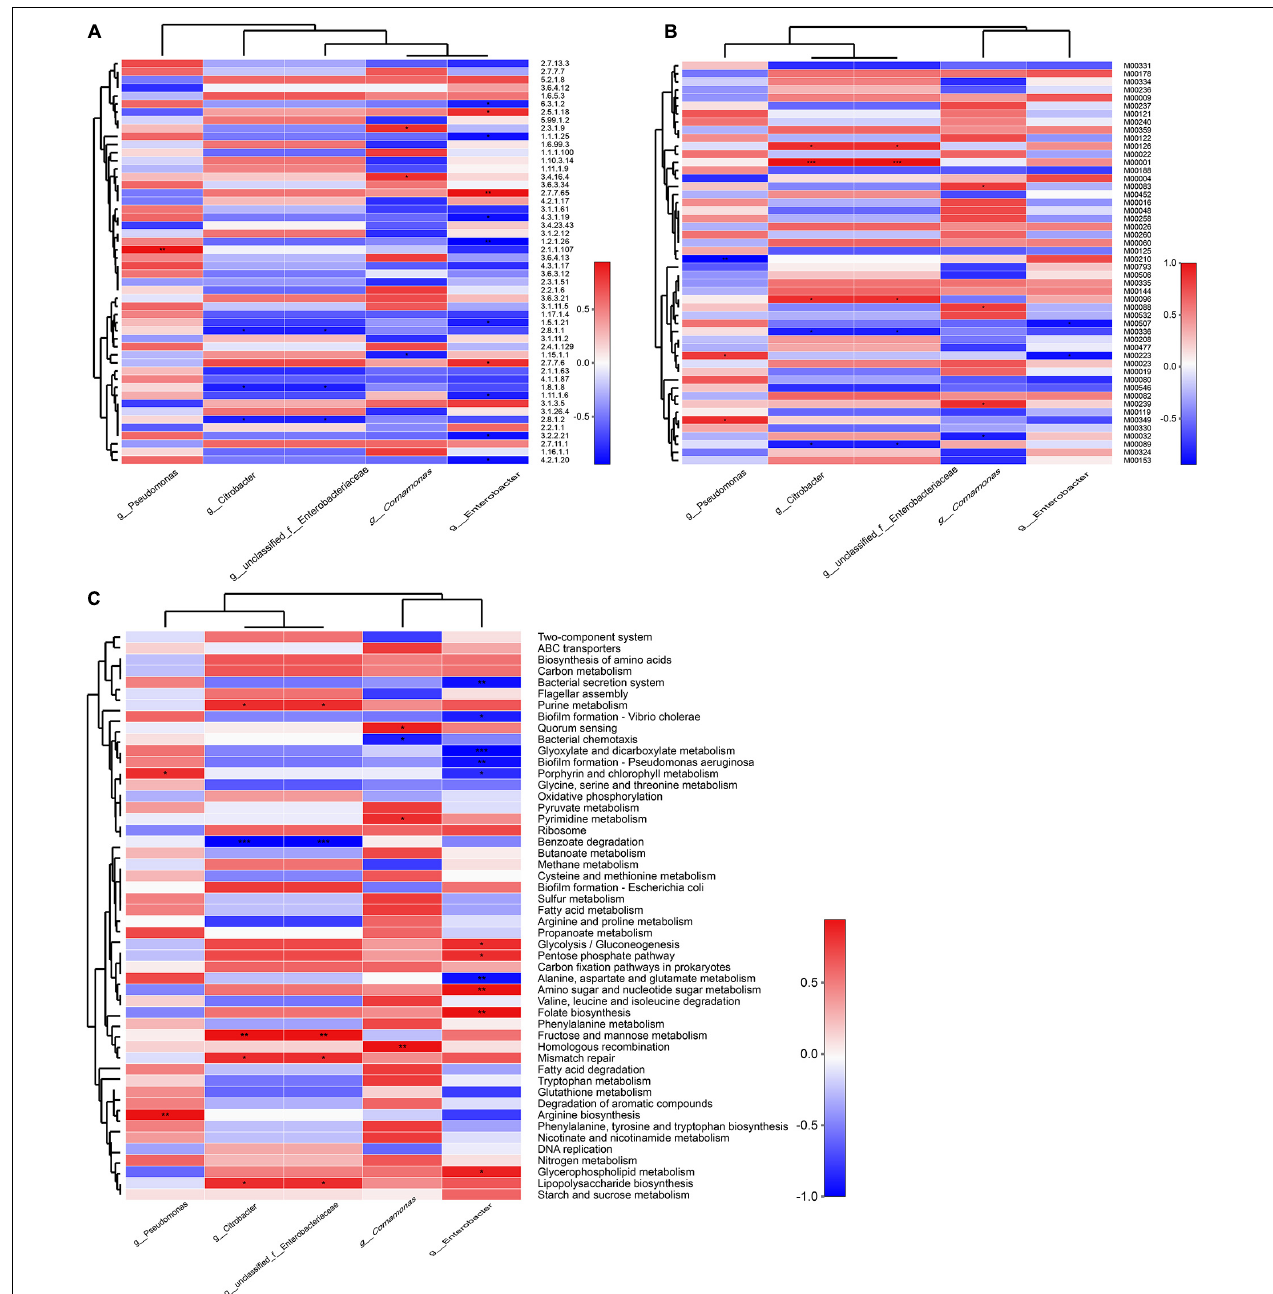
FIGURE 4 | Correlation of encoded functions and the most abundant microbial taxa. Cell colors denote correlation coefficient values based on the scales to the right of the heatmaps (* p < 0.05, ** p < 0.01, and *** p < 0.001). Profiles are shown for (A) enzyme profiles, (B) module profiles, and (C) KEGG pathway level